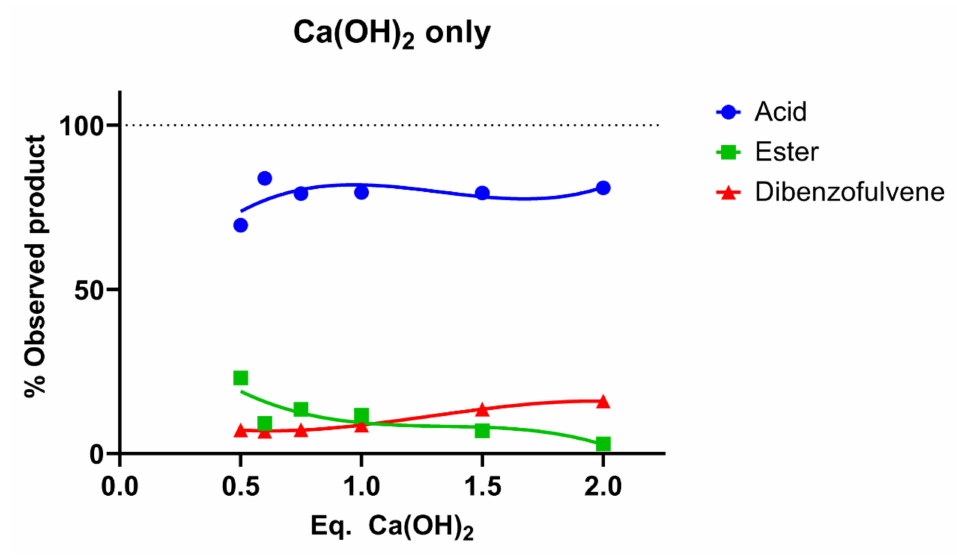
Figure 3. Screening number of equivalents of Ca(OH) 2 in an acetone/water ratio of 2.3:1 at RT for 4